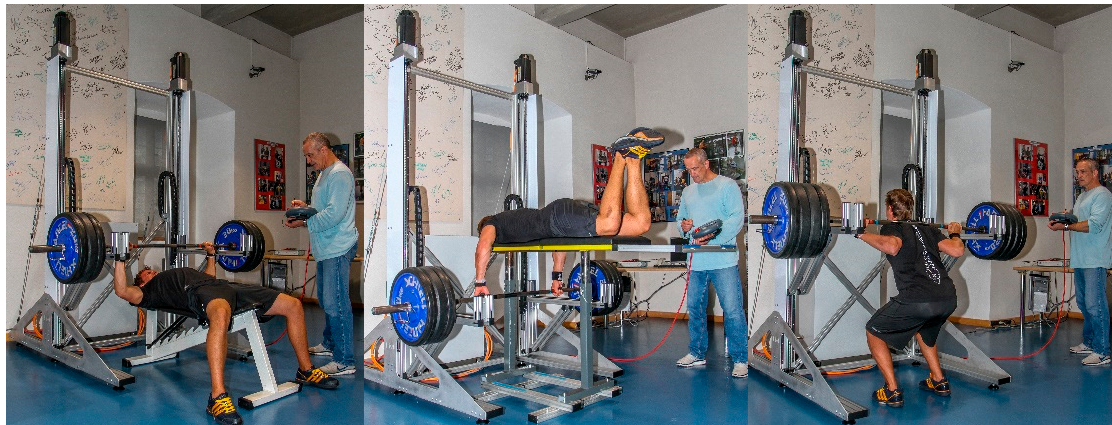
Figure 1. The Intelligent Motion Lifter © (IML) prototype in 2010. From left to right: bench press, bench pull and squat.